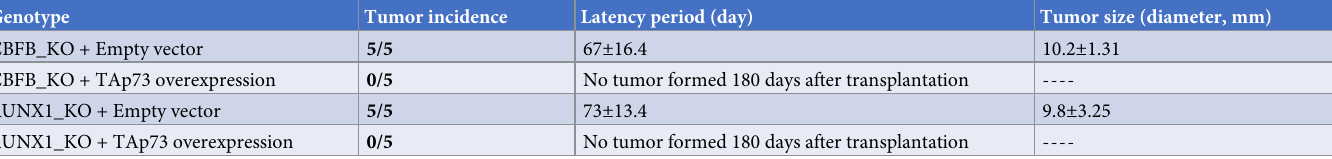
Table 1. Effect of TAp73 overexpression on the tumor formation of CBFB_KO and RUNX1_KO MCF10A cells. Five million MCF10A cells of various genotypes, as indicated, were subcutaneously transplanted into NSG mice. Tumor incidence: the number of mice having tumor formation/total number of transplanted mice. Latency period: the time from tumor cell injection to tumor collection (endpoint defined by the animal study protocol).